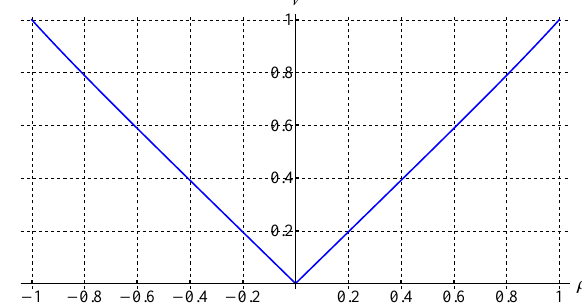
Figure 2: ν ( X , Y ) as a function of ρ for jointly normal X ,